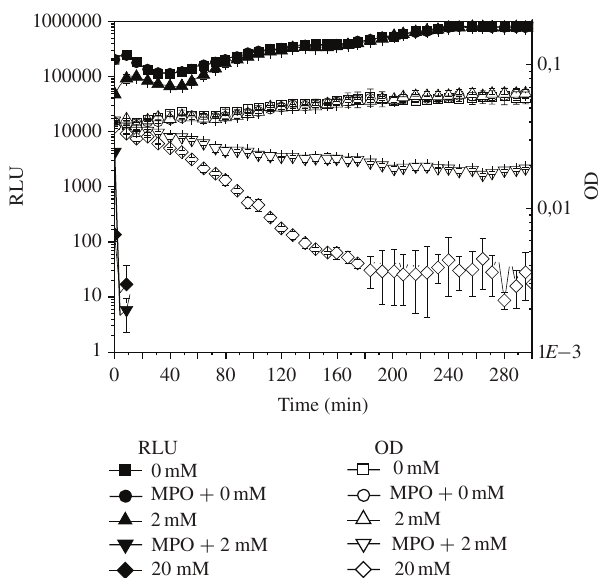
FIGURE 2: The bioluminescence signal and optical density (OD) of E. coli -lux (3 × 10 6 cells) incubated in the presence of various amounts of H 2 O 2 (mM) and 2 µ g/well MPO in phosphate buffer at 37 ◦ C. RLU: ( (cid:2) ) 0 mM, ( • ) MPO + 0 mM, ( (cid:6) ) 2 mM, ( (cid:3) ) MPO + 2 mM, and ( (cid:4) ) 20 mM; OD 620 nm : ( (cid:5) ) 0 mM, ( (cid:3) ) MPO + 0 mM, ( (cid:7) ) 2 mM, ( ∇ ) MPO + 2 mM, and ( ♦ ) 20 mM of H 2 O 2 . Relative luminescence unit (RLU) and OD values are shown as the mean ± SD of measurements from three parallel